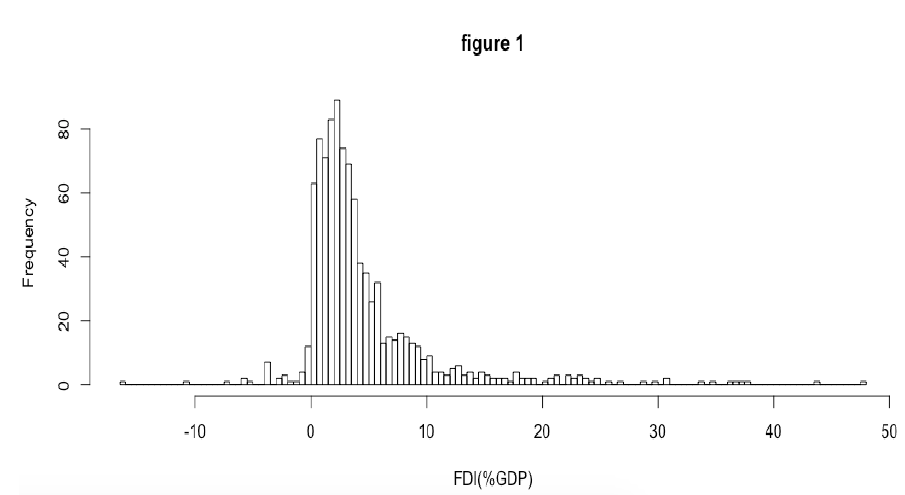
Figure1. The distribution of FDI. Most of the observations are within the range +30% and 10%. The figure reveals positive strong positive skewness for FDI.